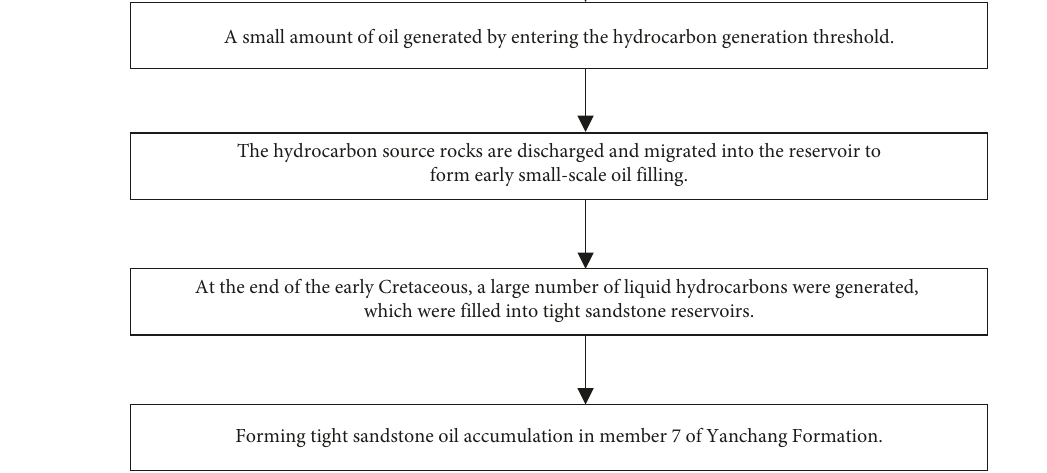
Figure 1: Hydrocarbon accumulation process in the Ordos basin. Table 4: Basic physical parameters of natural tight sandstone core